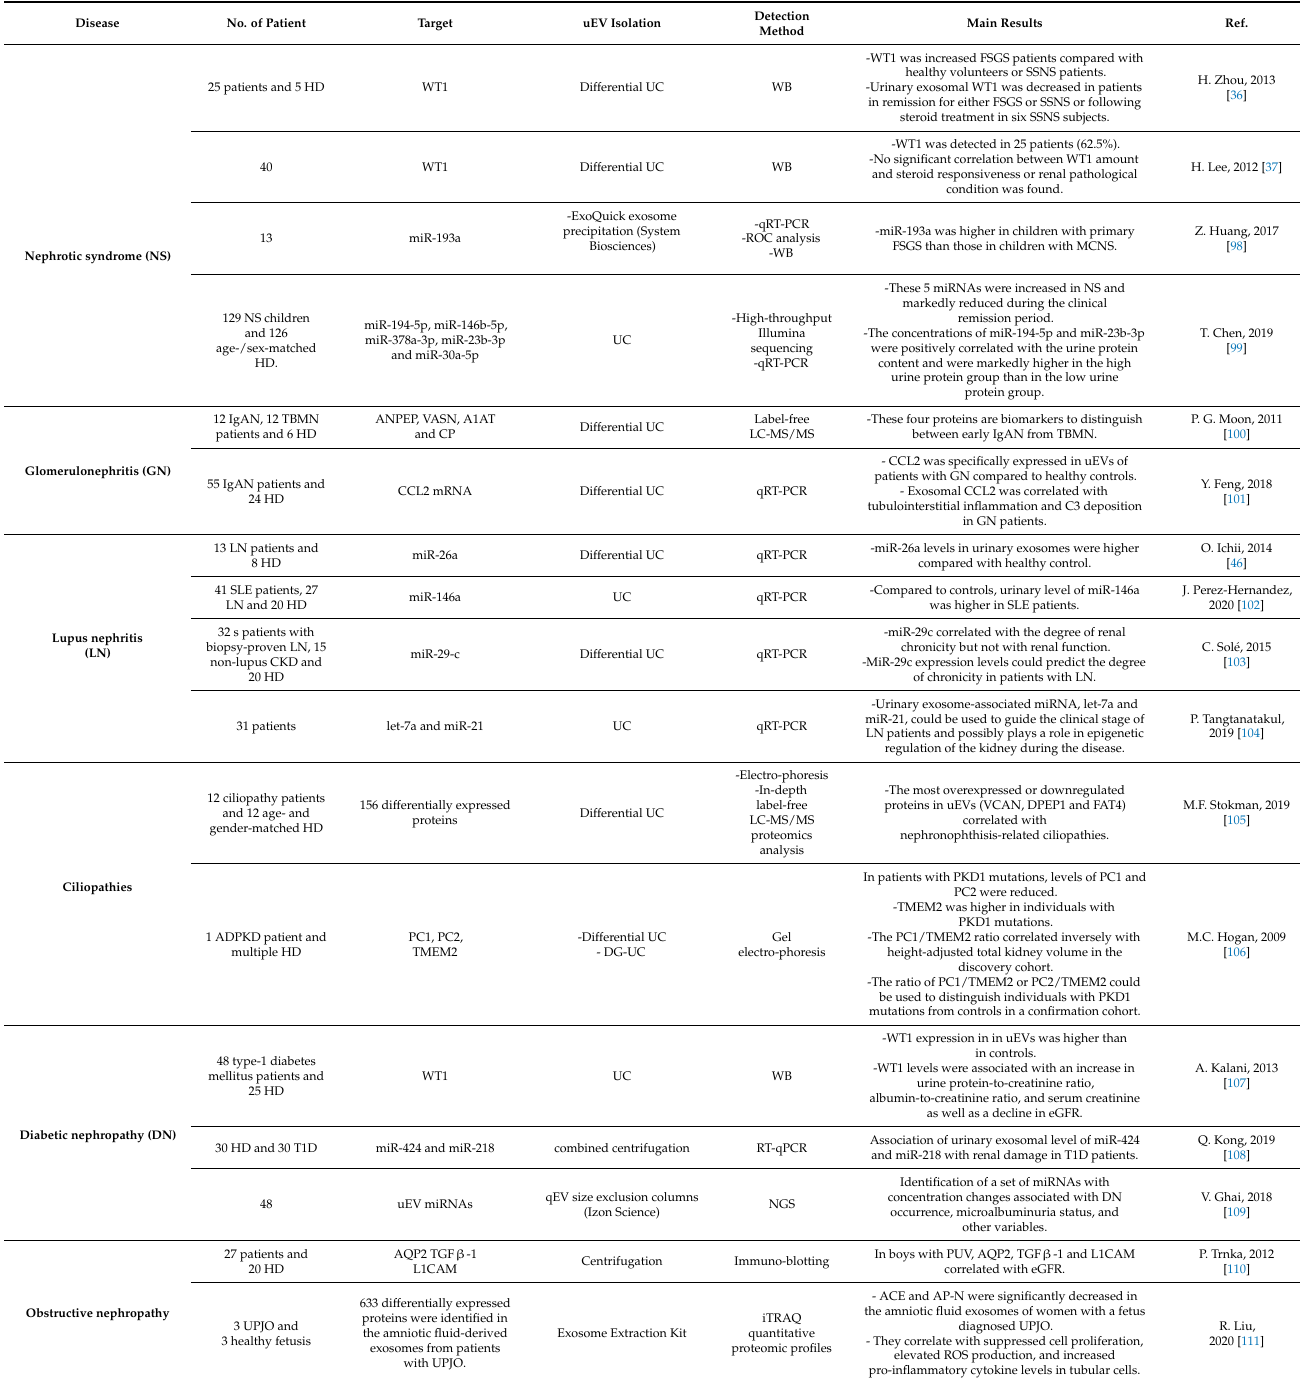
Table 2. uEV biomarkers for clinical diagnosis of kidney-related diseases: a summary of human studies.